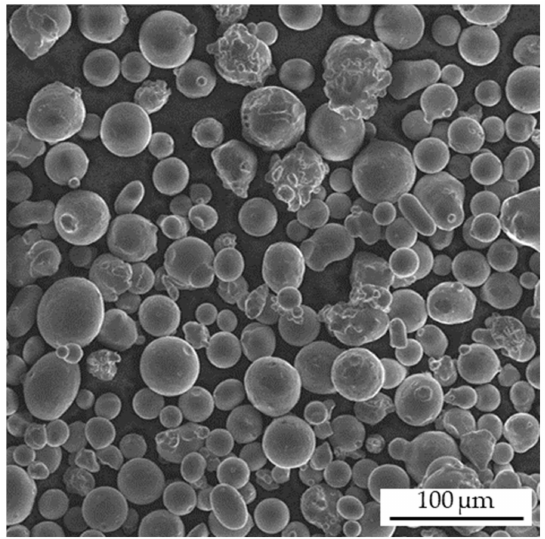
Figure 1. SEM-micrograph of AISI 318LN powder particles.